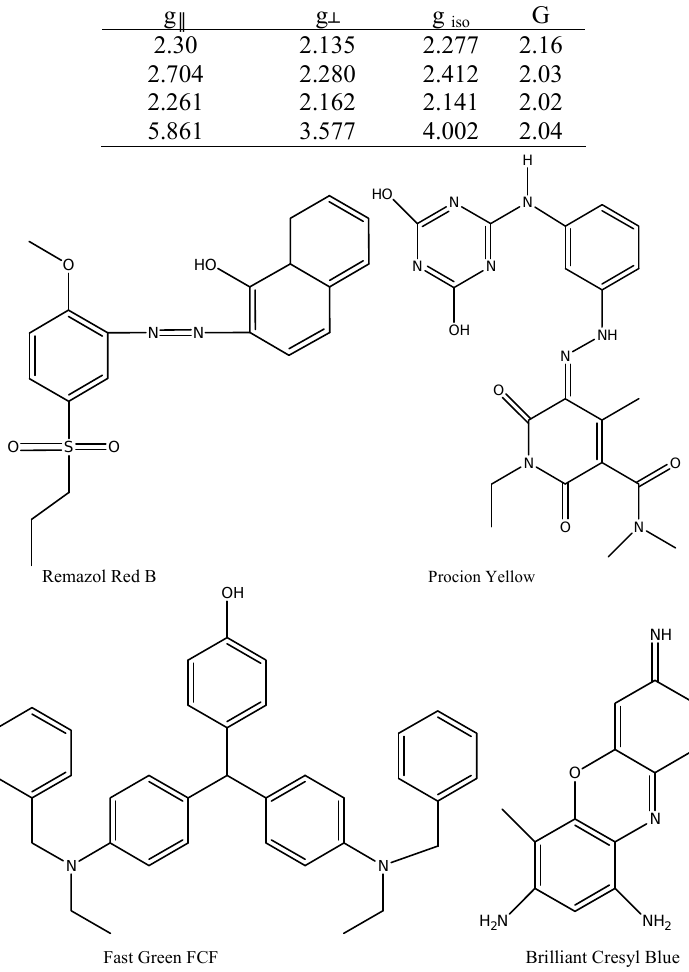
Table 4. EPR spectral data of the dye-copper complexes at RT